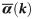
Average risk attitude α¯(k) of the network in the reference scenarios (magenta line) and in the rational market (blue line).